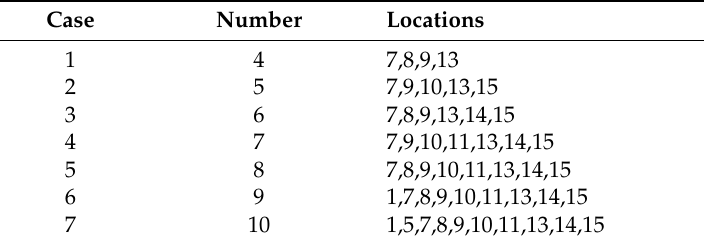
Table 6. Number and optimized locations of additional virtual masses.